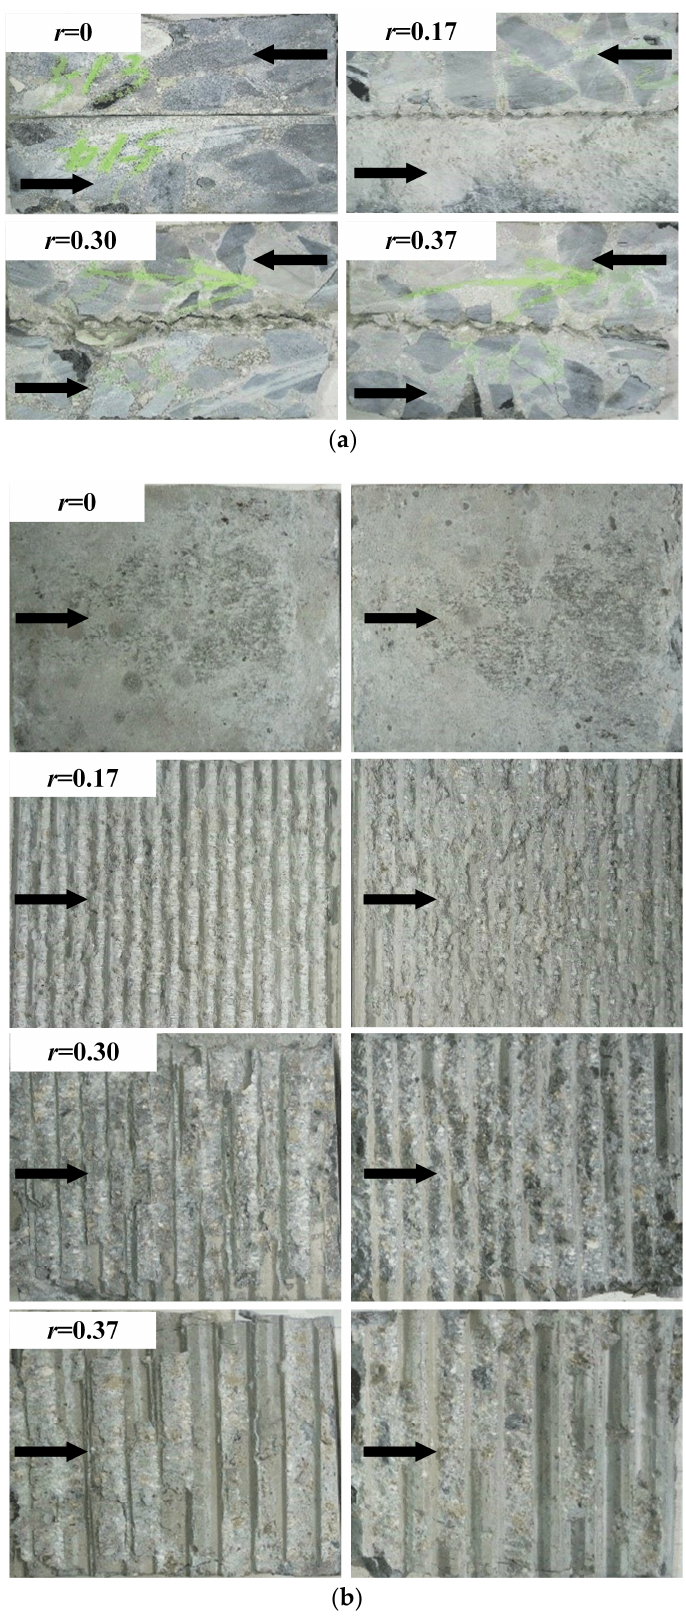
Figure 11. Shapes of dentate joints after shear failure under different roughness: ( a ) shapes of dentate joints; ( b ) joints surface.